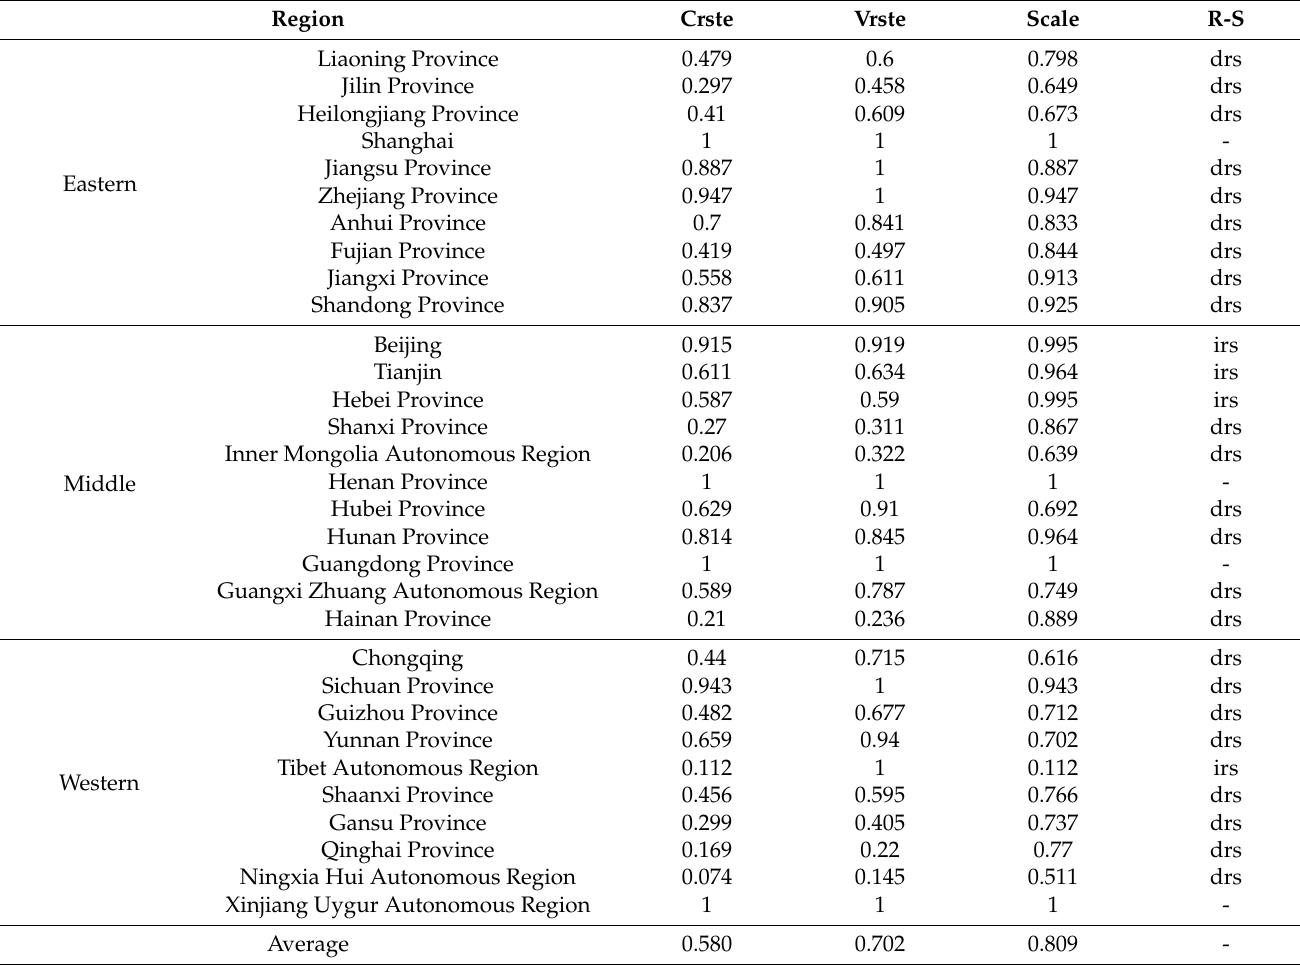
Table 2. Input–output efficiency values of medical